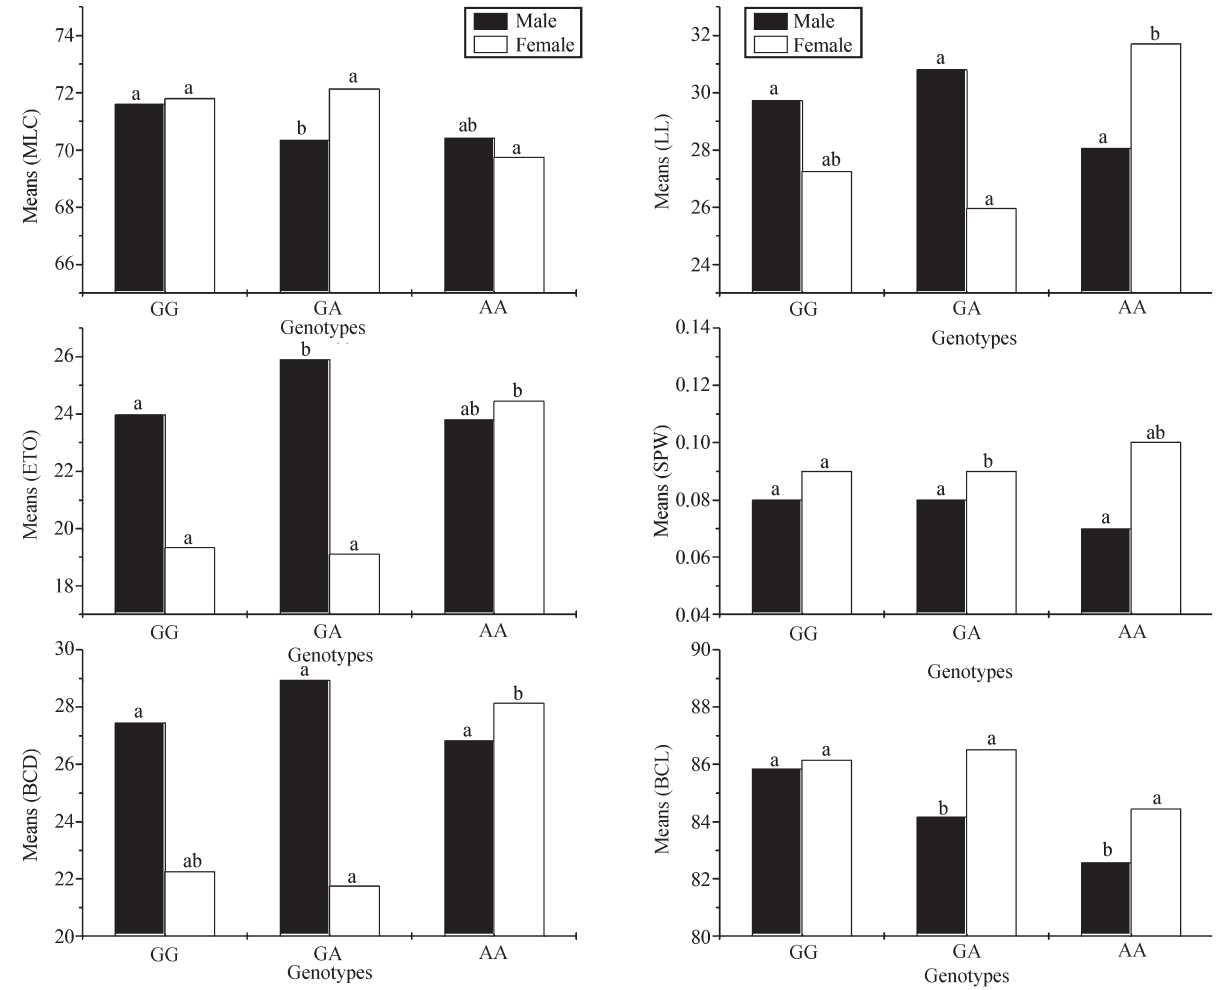
Figure 2 - Variation of trait means obtained for the G316A genotypes within each sex in F2 pigs. For each sex, means followed by the same letter are not significantly different (t-test, p < 0.05). BCL = carcass length measured by the Brazilian carcass classification method; MLC = carcass length measured by the American carcass classification method; LL = backfat thickness between last and next to last but one lumbar vertebra, at midline; ETO = backfat thickness after last rib, 6.5 cm from the midline, equivalent to P2; SPW = spleen weight; and BCD = bacon